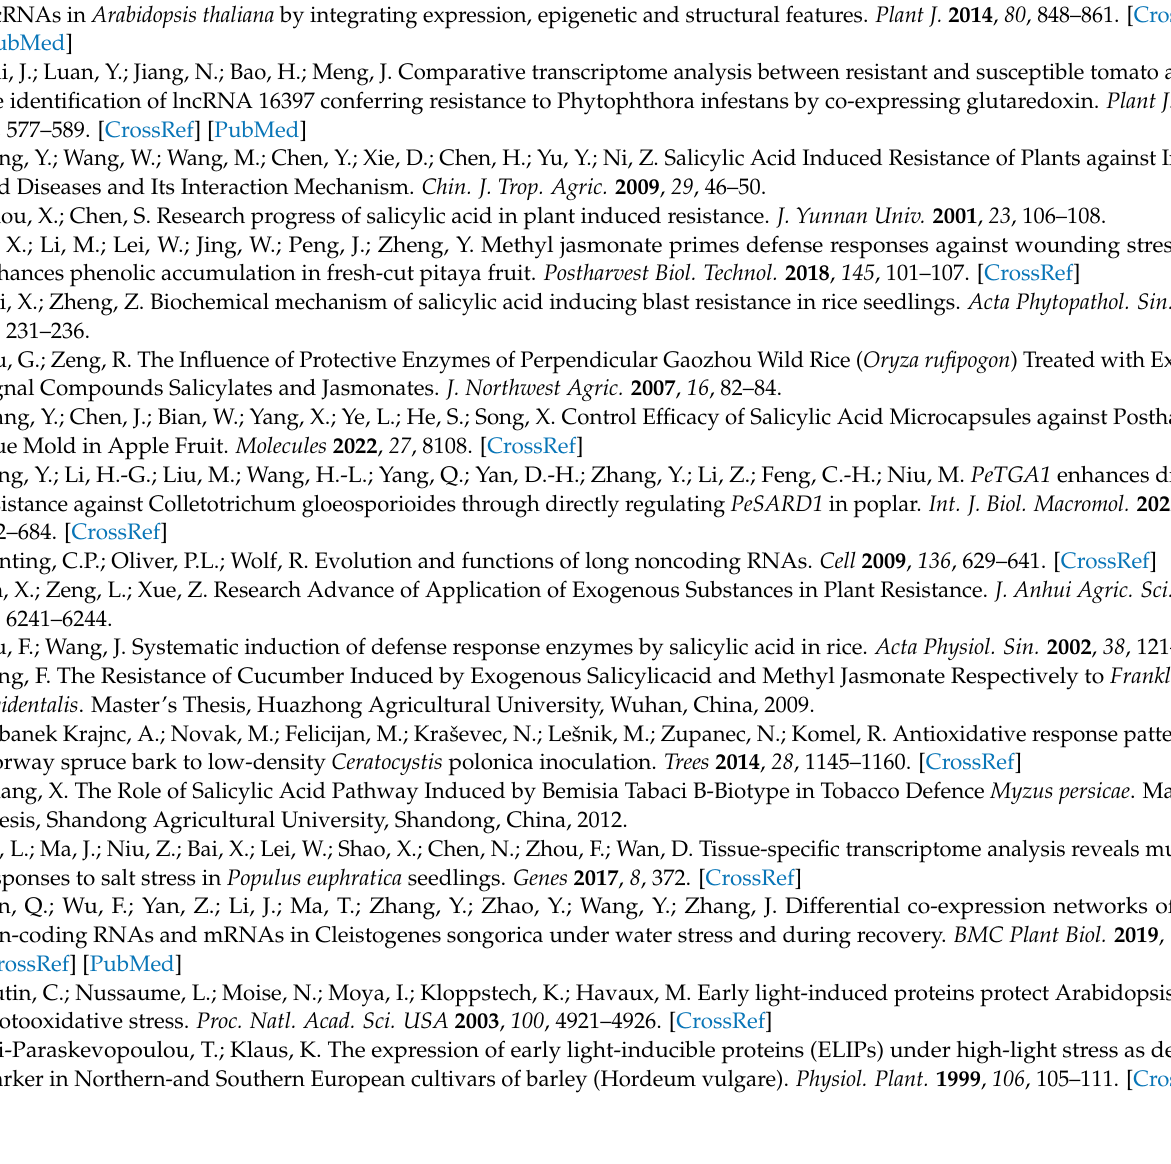
Table S2: Summary of Populus × euramericana lncRNA data; Table S3: Summary of differentially expressed genes; Table S4: Summary of differentially expressed lncRNAs; Table S5: The significant GOs of DEGs; Table S6: The significant pathways of DEGs; Table S7: Primers used for real-time quantitative